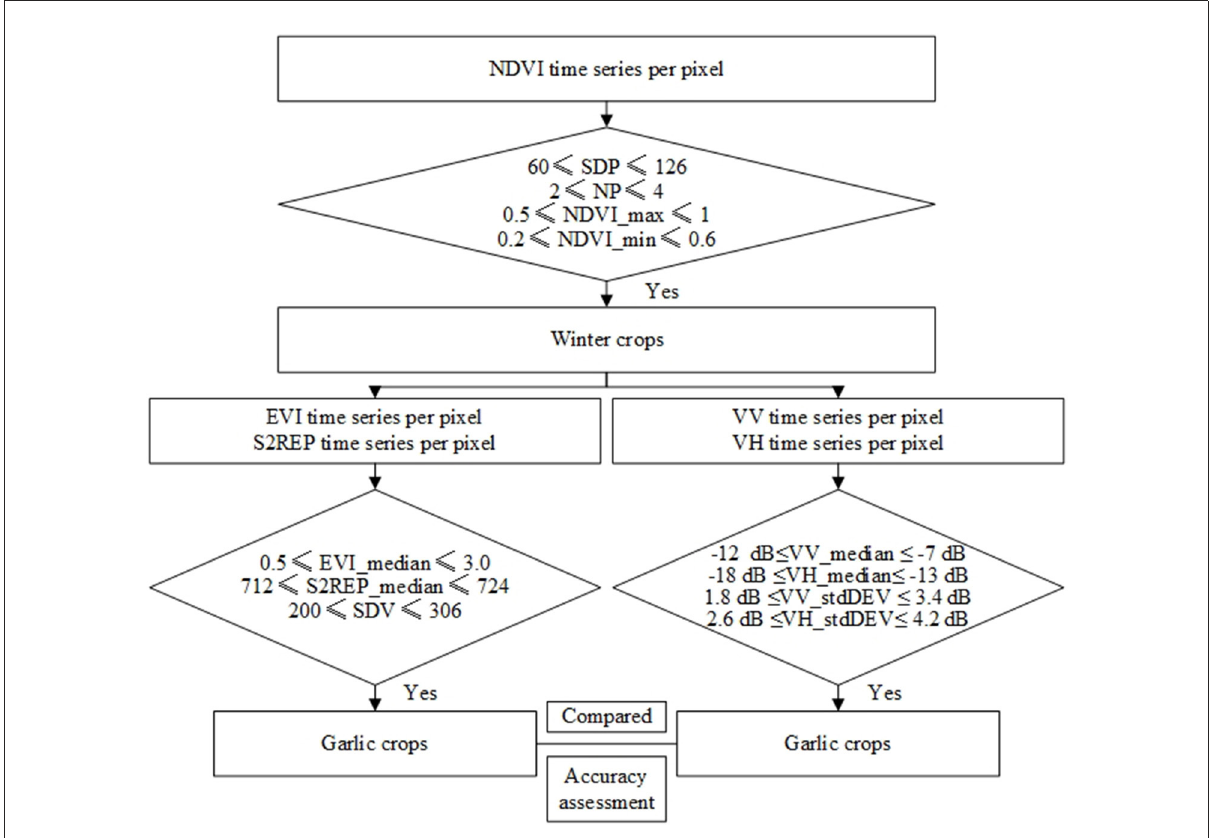
FIGURE5 The algorithm framework for identifying